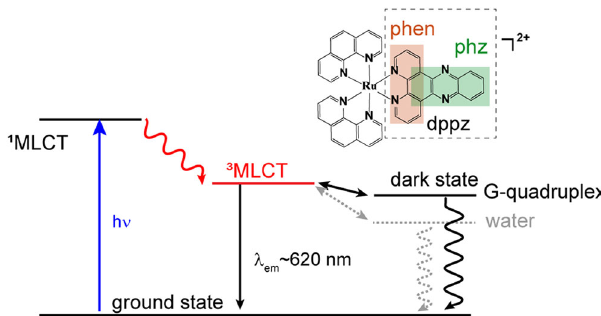
Fig. 1 Jablonski diagrams for the photophysical processes of [Ru (phen) 2 (dppz)] 2 + . The phenanthrolin (phen) and phenazine (phz) moieties of dppz ligand are highlighted in the molecular